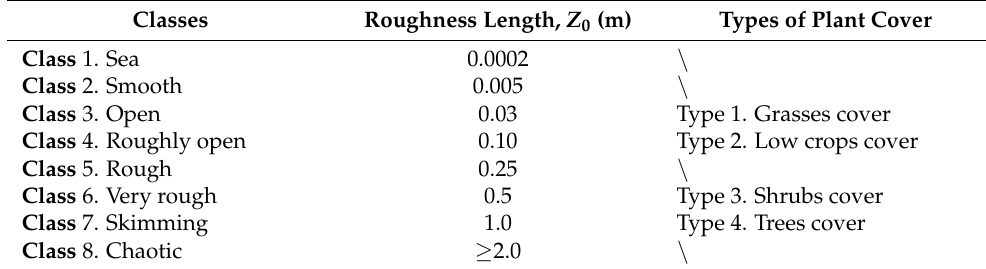
Table 4. Summaries of roughness